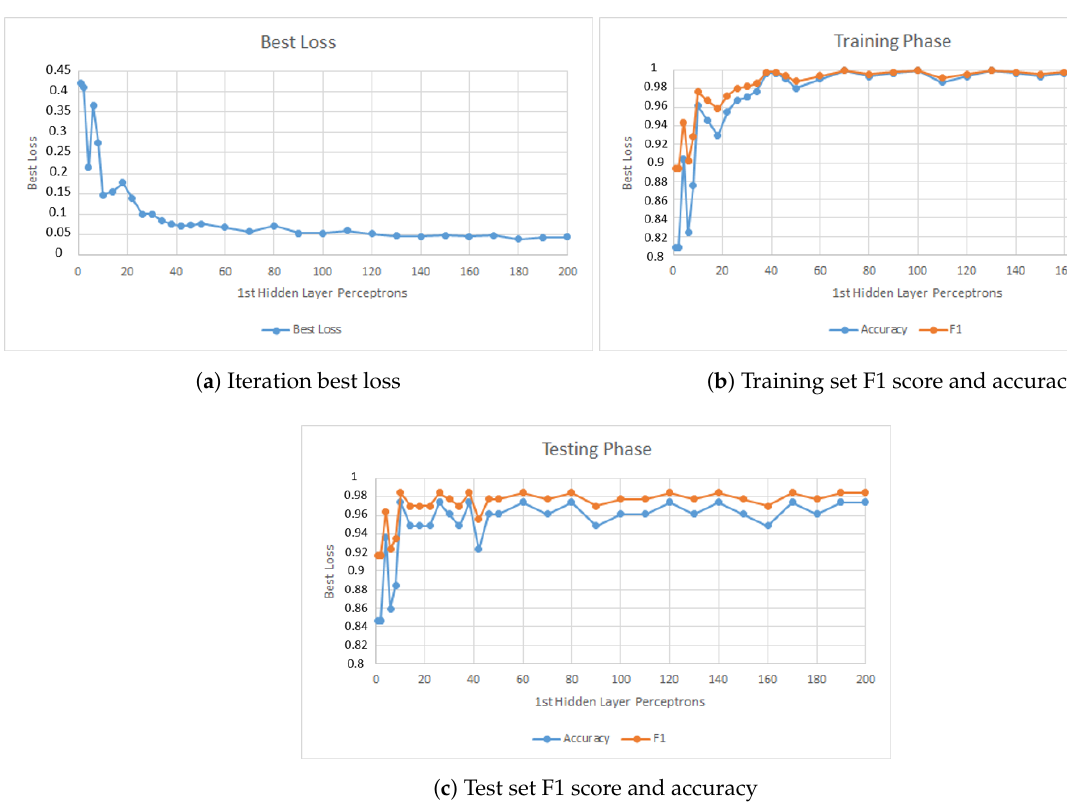
Figure 8. Model behavior when changing the number of perceptrons in the first hidden